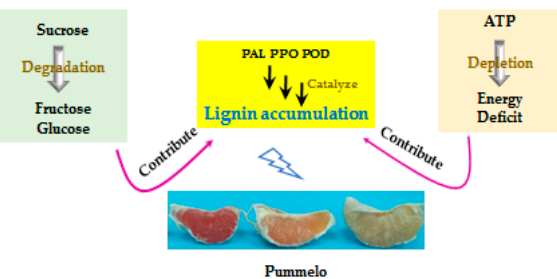
Figure 6. Probable mechanism of lignin accumulation in juice sacs of three pumelo cultivars by acting on the metabolism of sugar and energy.